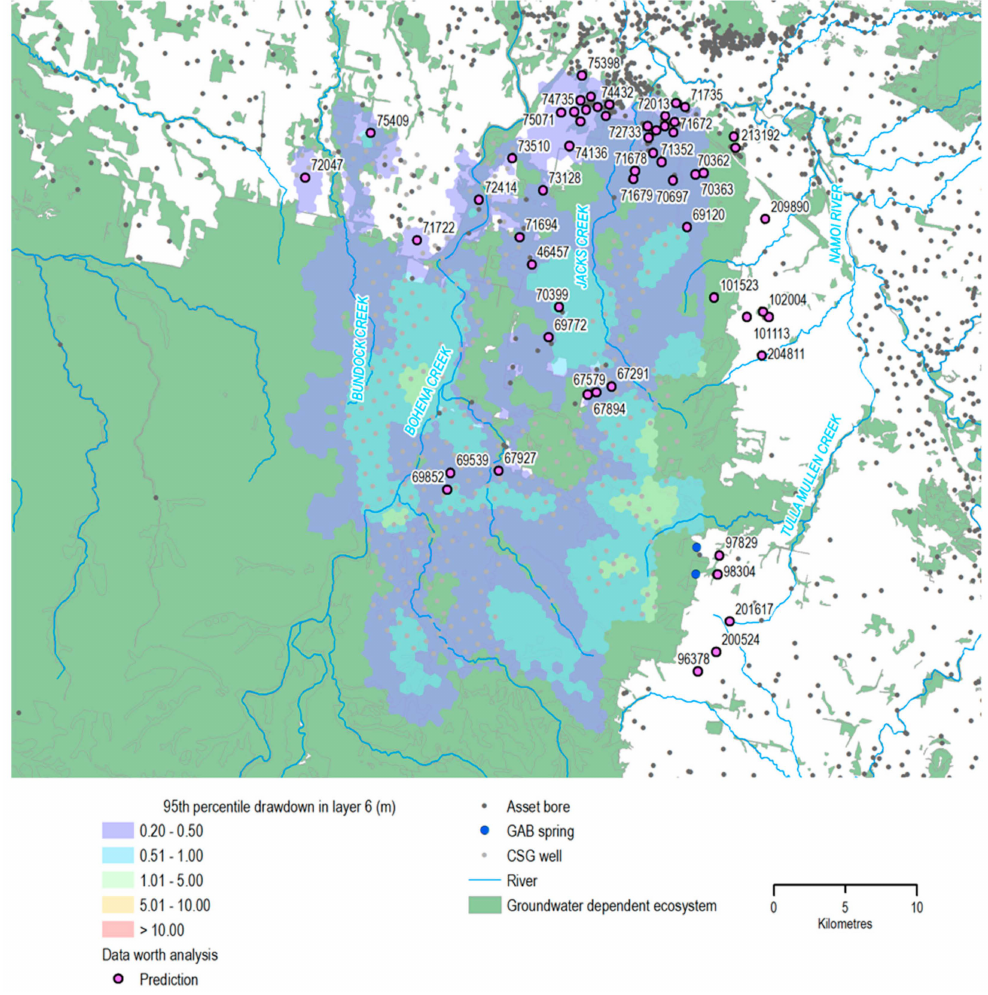
Figure 10. Receptor location for which data-worth analysis for drawdown prediction was